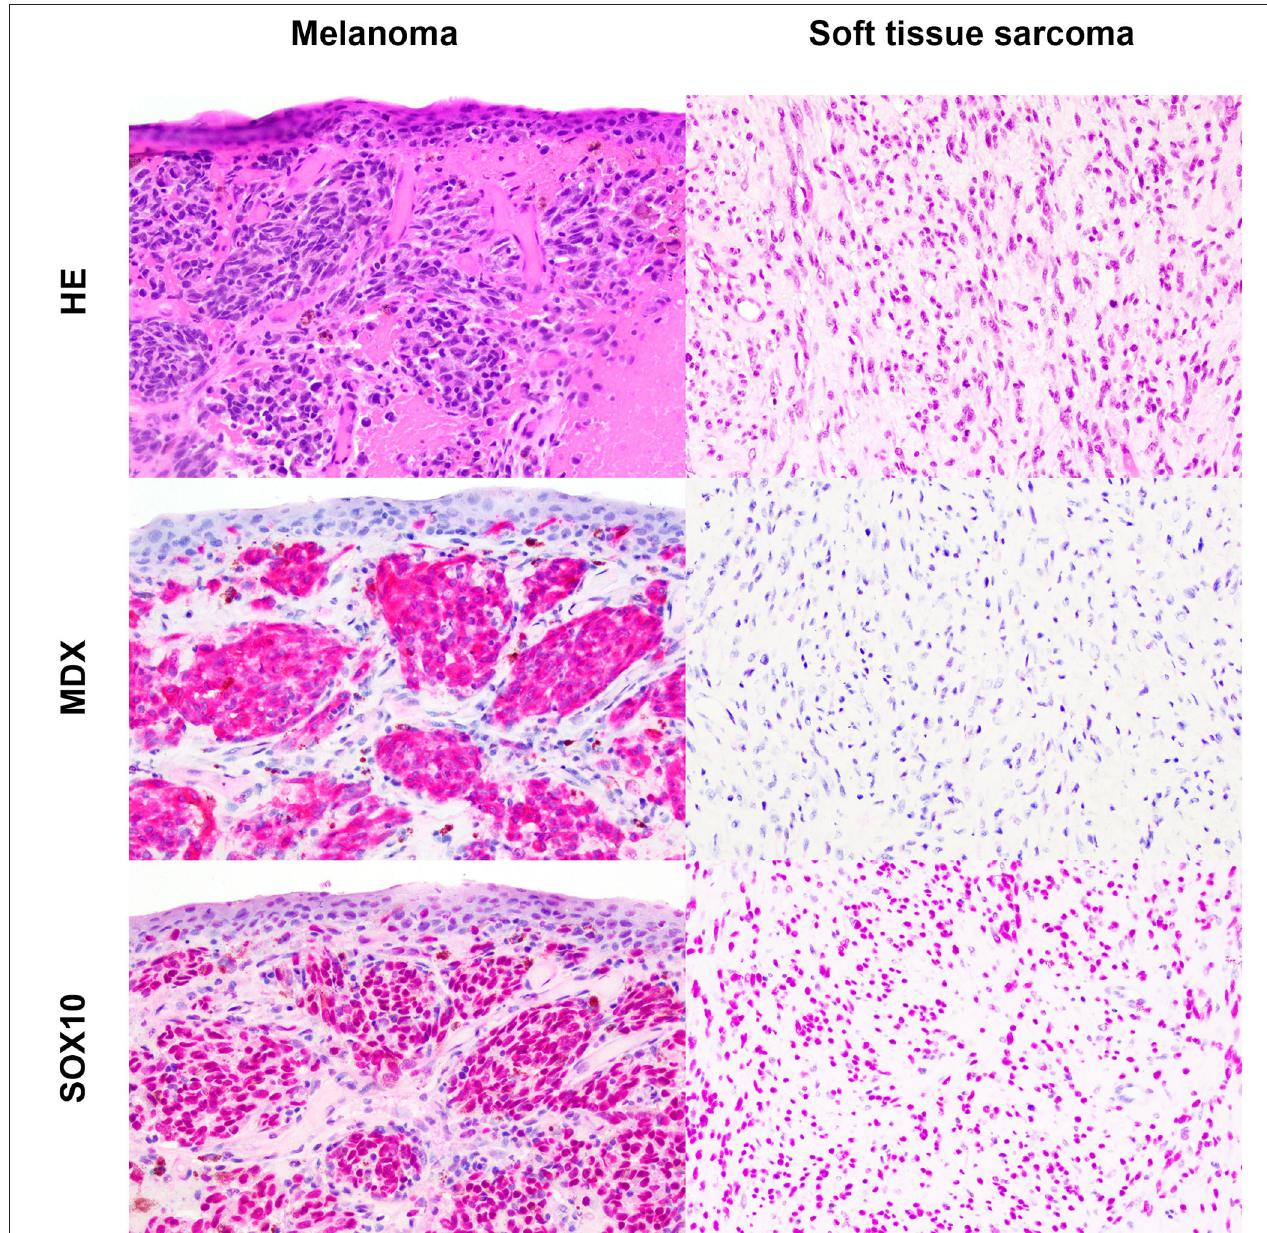
FIGURE 4 | Oral malignant melanoma (OMM) and soft tissue sarcoma (STS) stained with hematoxylin and eosin or immunohistochemically labeled with the melanoma immunodiagnostic cocktail (MDX; red cytoplasmic labeling) or SOX-10 (red nuclear labeling) with hematoxylin counterstaining. OMM with red cytoplasmic labeling for MDX with a score of 3 and red nuclear labeling for SOX-10 with a score of 3. STS negative for MDX and red nuclear labeling for SOX-10 with a score of 3. Magnification, × 20.